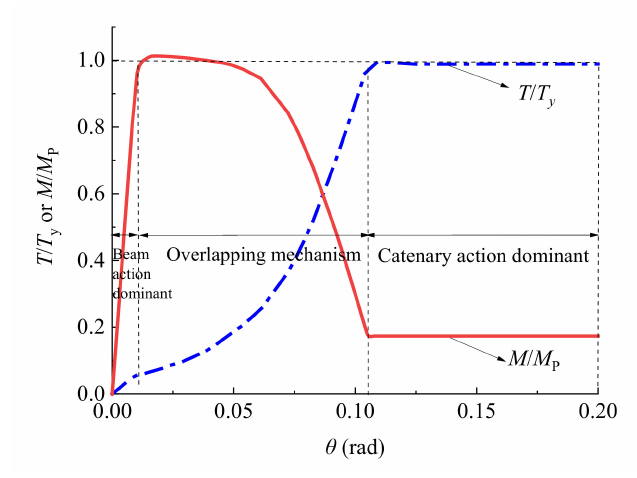
Figure 12. Axial tension–bending moment interaction at beam ends of model S.